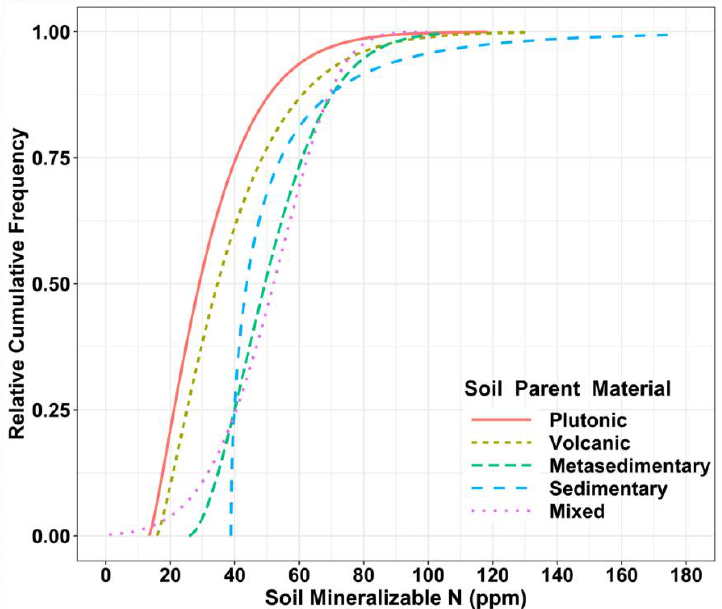
Figure 2. Soil mineralizable nitrogen cumulative distributions for different bedrock soil parent materials in the Inland Northwest, USA.